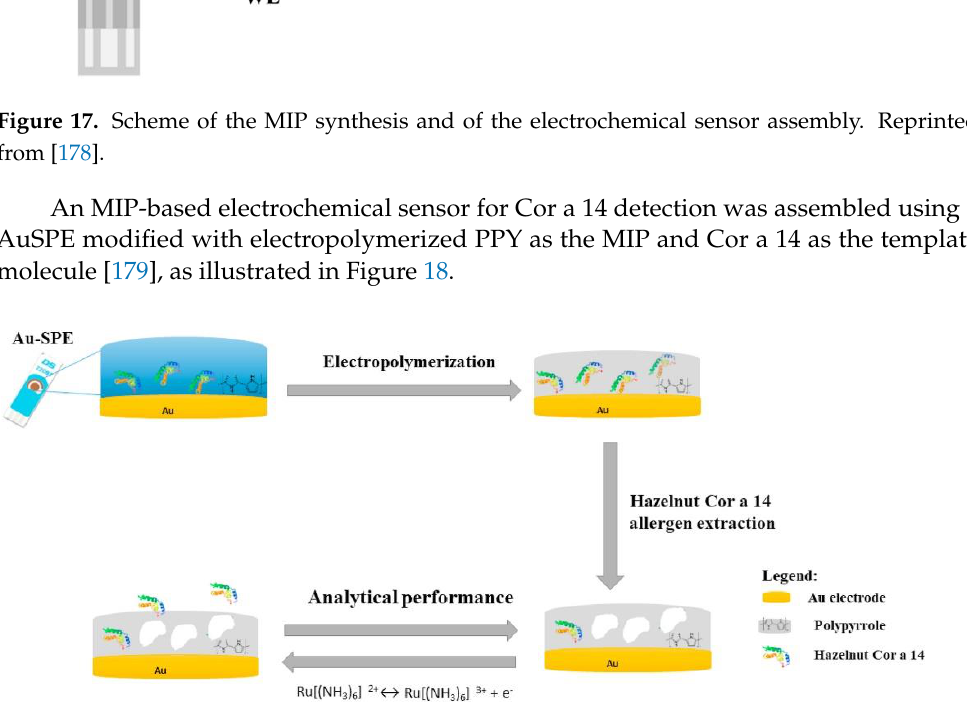
Figure 18. Scheme illustrating the different steps involved in the MIP assembly and electrochemical detection of hazelnut Cor a 14 allergen. Reprinted with permission from [179]. Copyright 2022, Else- vier .